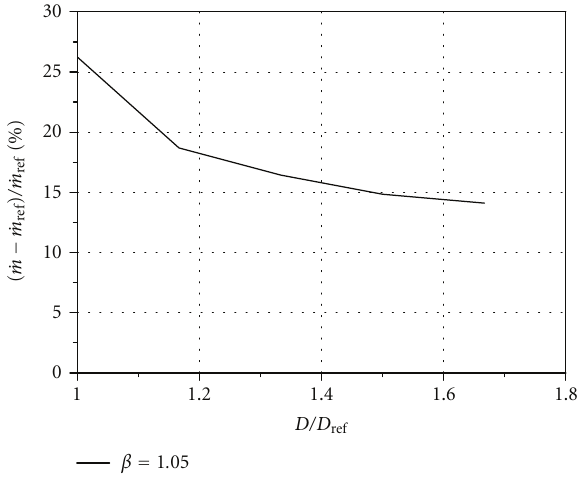
Figure 18: Total coolant mass flow rate varying the D/D ref